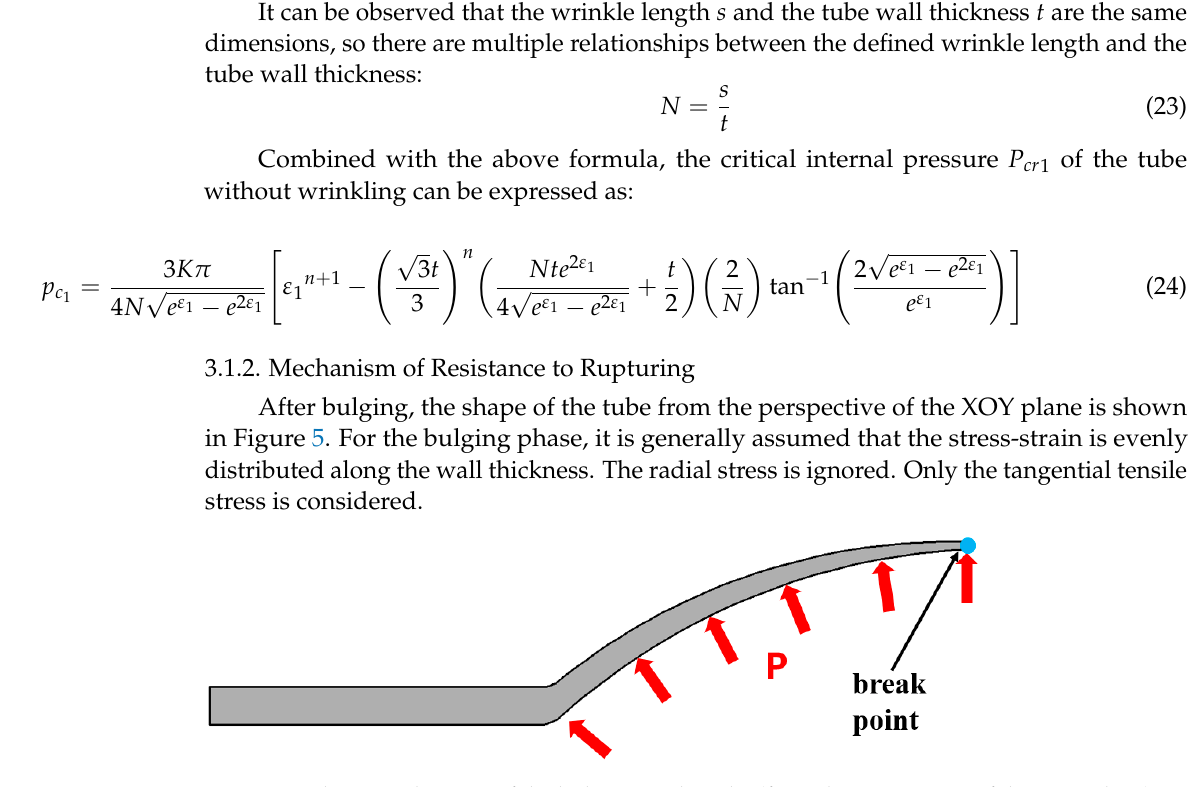
Figure 5. Schematic diagram of the bulging on the tube (from the perspective of the XOY plane). Under the drive of internal pressure, the tube is expanded to the maximum diameter. Taking a unit width of the tube for analysis, according to the equilibrium conditions of the round tube, it can be obtained that: